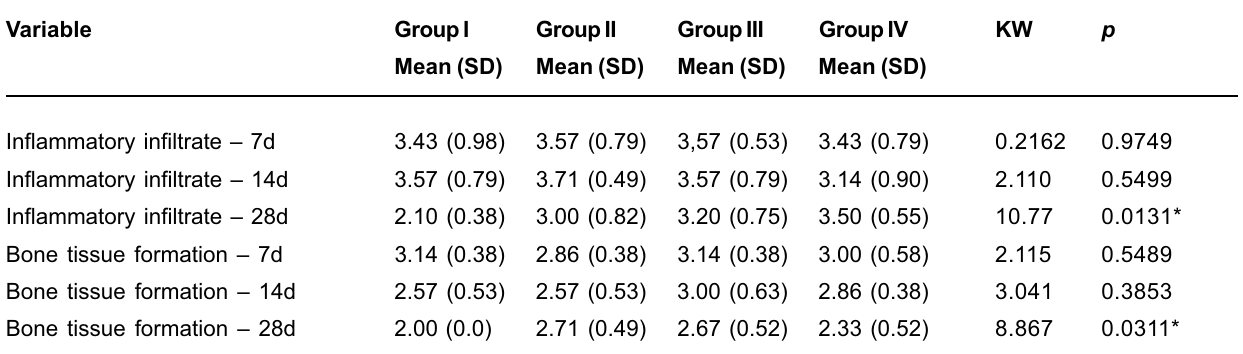
SD= standard deviations; KW= Kruskal-Wallis; * Significant difference at p<0.05.